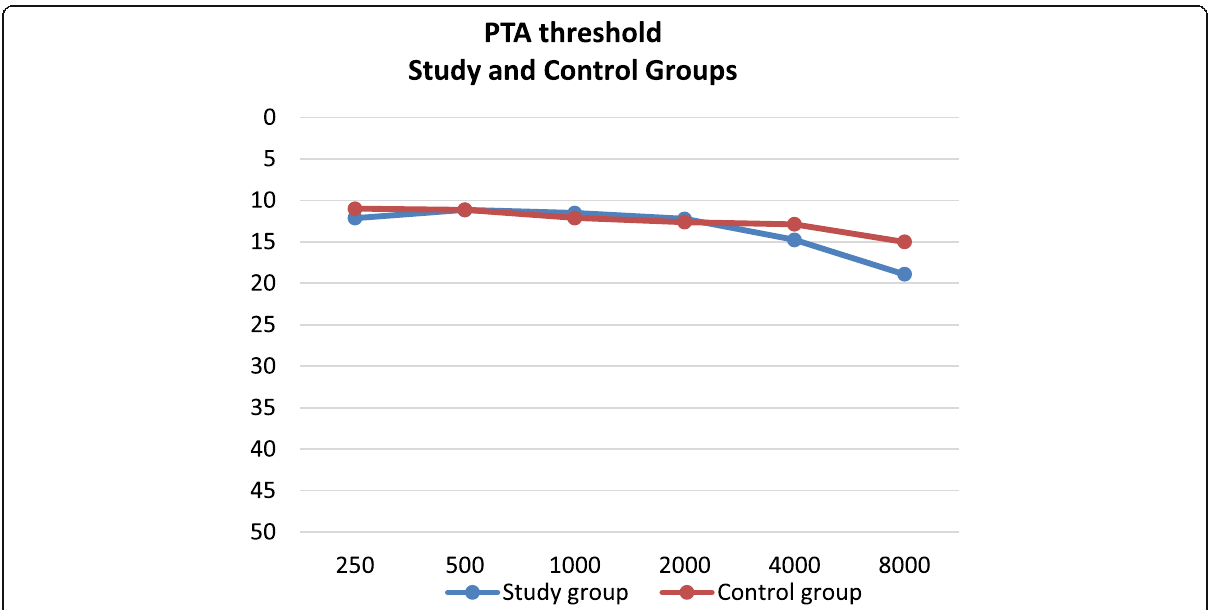
Fig. 1 Mean pure tone thresholds (dB HL) for both study and control groups